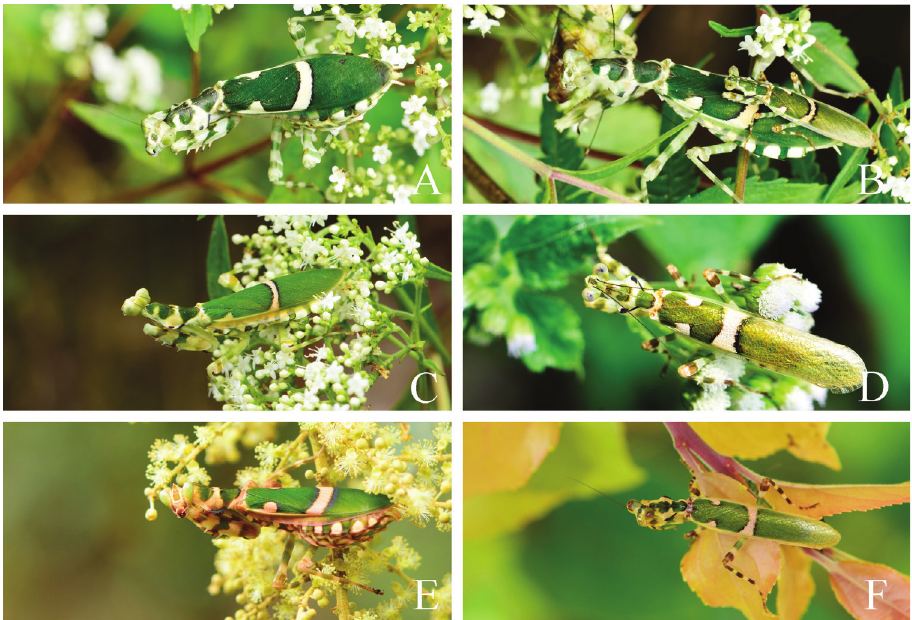
Figure 13. Theopropus spp. adult in its natural habitat A, B T. sinecus sinecus C T. sinecus qiongae ssp. nov. D T. xishiae sp. nov. E, F T. sp. A, C, E female B pair D, E